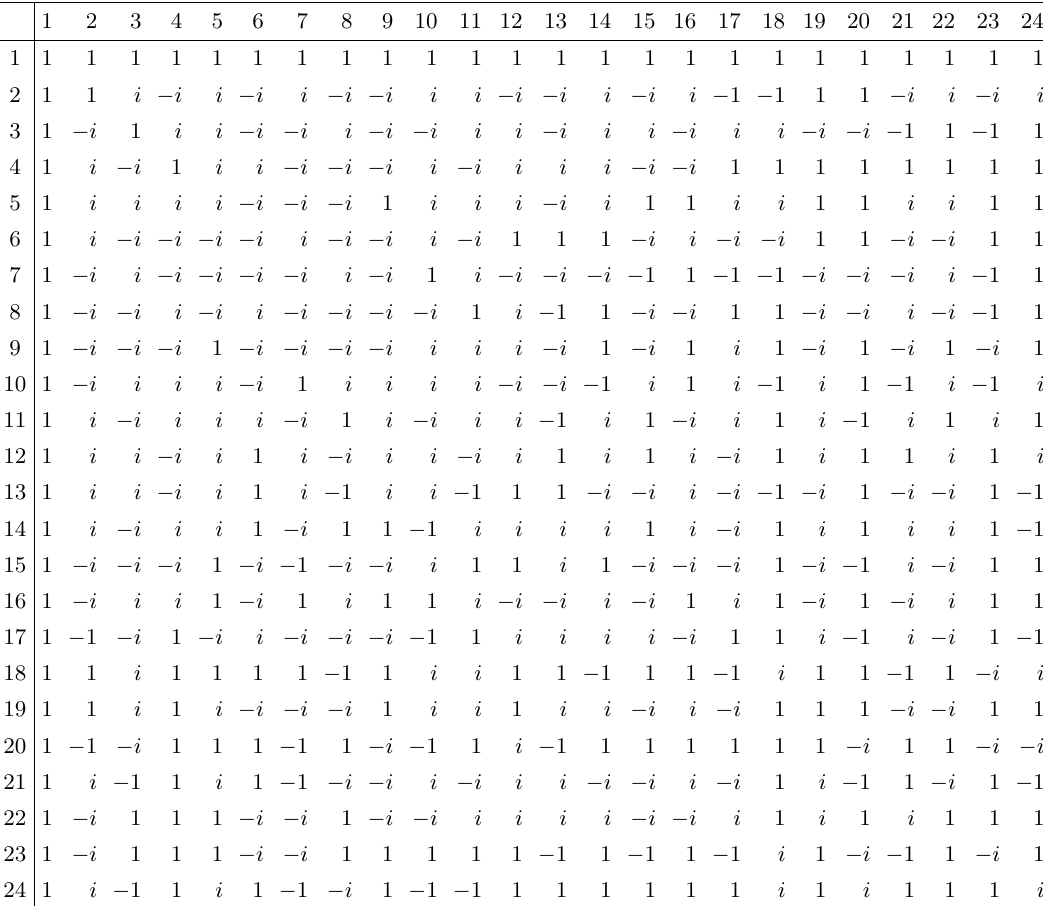
indicates that a maps to b , b maps to c , and c maps to a , so that, for example, ( abc ) = ( bca ) = ( cab )